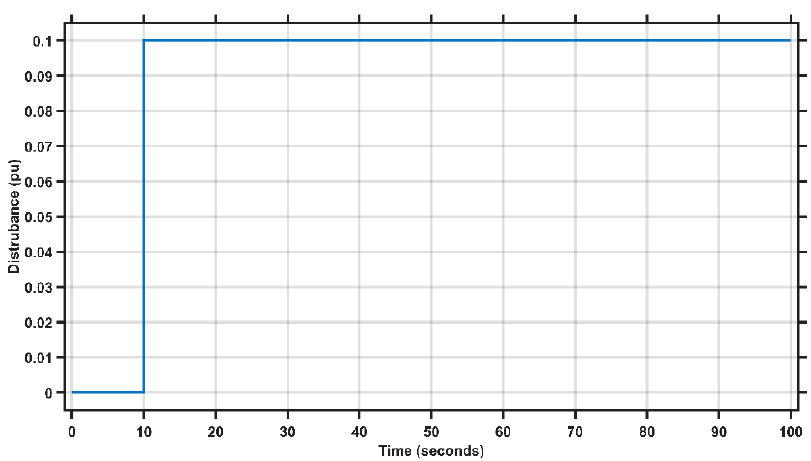
Figure 7. Step disturbance of case 1.